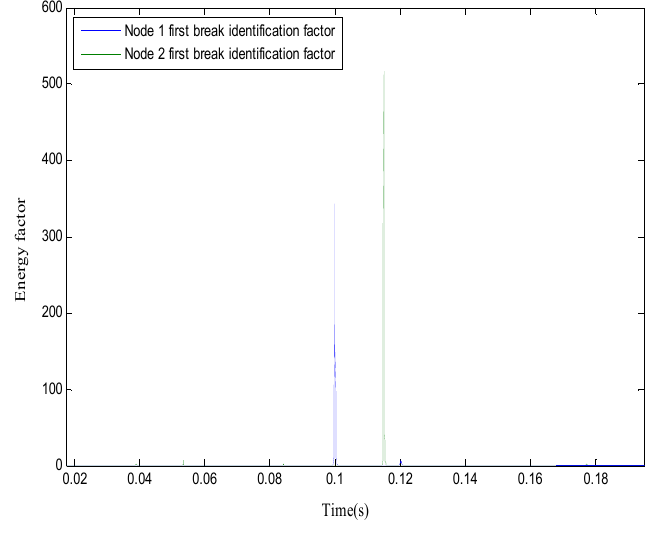
Figure 20. Identification factor graph.